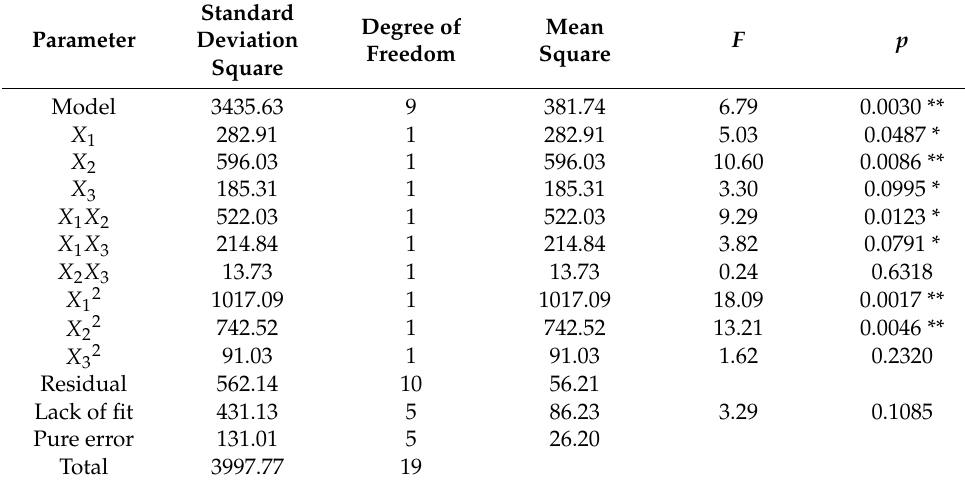
Table 3. Analysis of variance of qualified